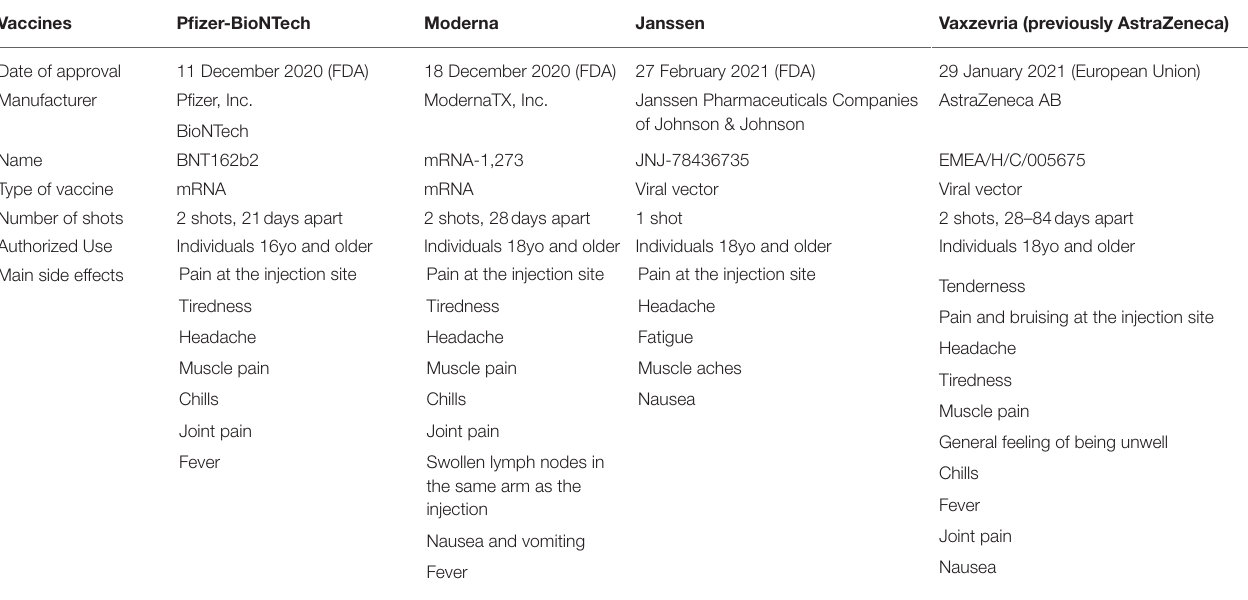
TABLE 2 | Comparison of the COVID-19 vaccines approved by FDA and EMA (FDA, 2021; CDC, 2021c; European Medicines Agency, 2022).